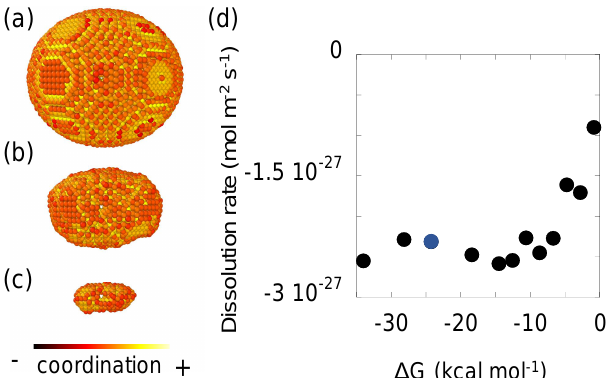
Figure 5. Quartz grain dissolution study with ∆ G . ( a ) Initial grain. ( b ) Grain after half of the forming atoms have dissolved. ( c ) 10% of the atoms remain. ( d ) Dissolution rate versus ∆ G curve. Blue point corresponds to the simulation of the topographies in ( a – c ), though similar topographies are obtained in any other point. The visual representation is done using OVITO program.